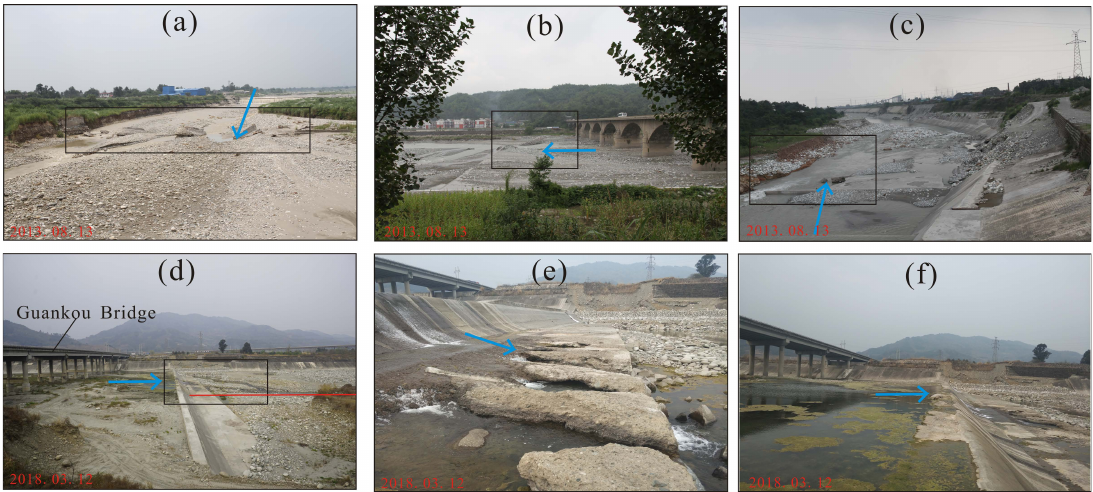
Figure 3. Pictures of the damage of bed sills: ( a ) entire failure of the bed sill downstream from an overfall dam; ( b ) local damage of the bed sill downstream from a bridge; ( c ) terrible scour downstream from Jianjiang Dam, where the broad bed sill and the embankments were demolished; ( d ) scour downstream of a newly built bed sill downstream from Guankou Bridge, where the left bank was destroyed, and the undercutting depth of the bed was more than 1.0 m; ( e ) local exposure and erosion of the toe board downstream of the bed sill, downstream of which the precast concrete blocks for local scour protection were washed away to a lower reach; and ( f ) bad water quality upstream of the bed